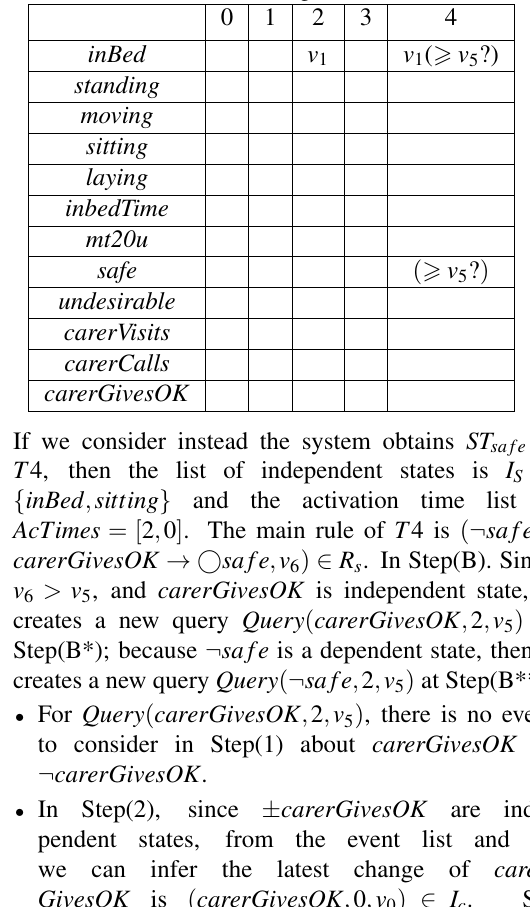
Table 6. The Searching Process of T3